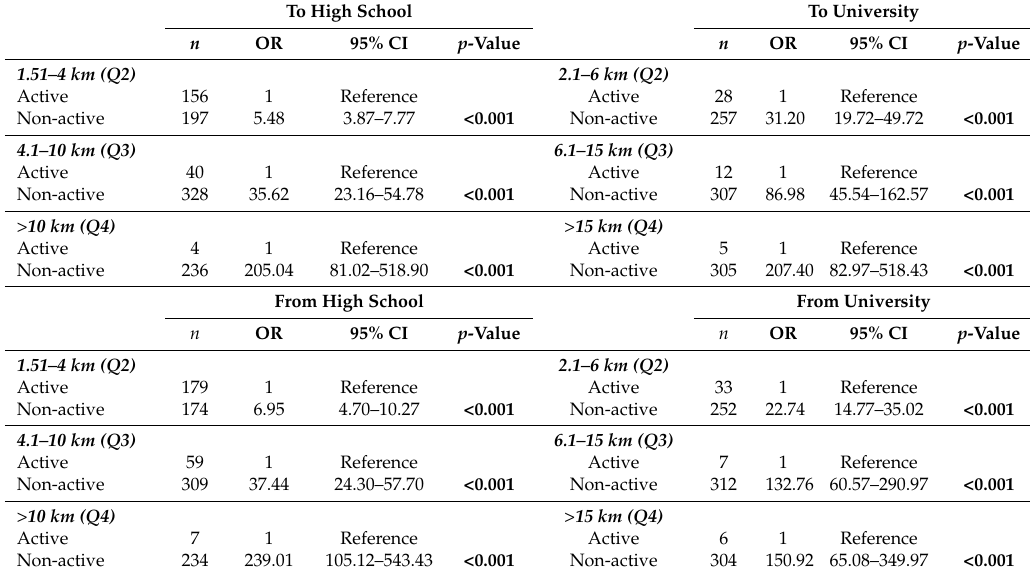
Table 4. Probability of being active or non-active, according to distance from high school and university to home and vice